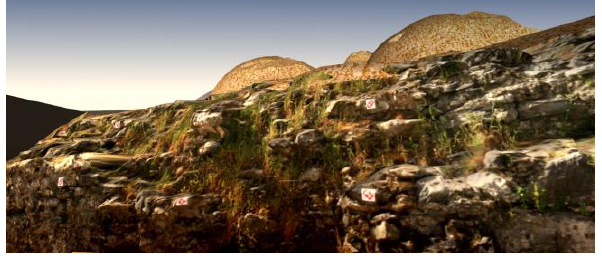
Figure 18. North west perspective view